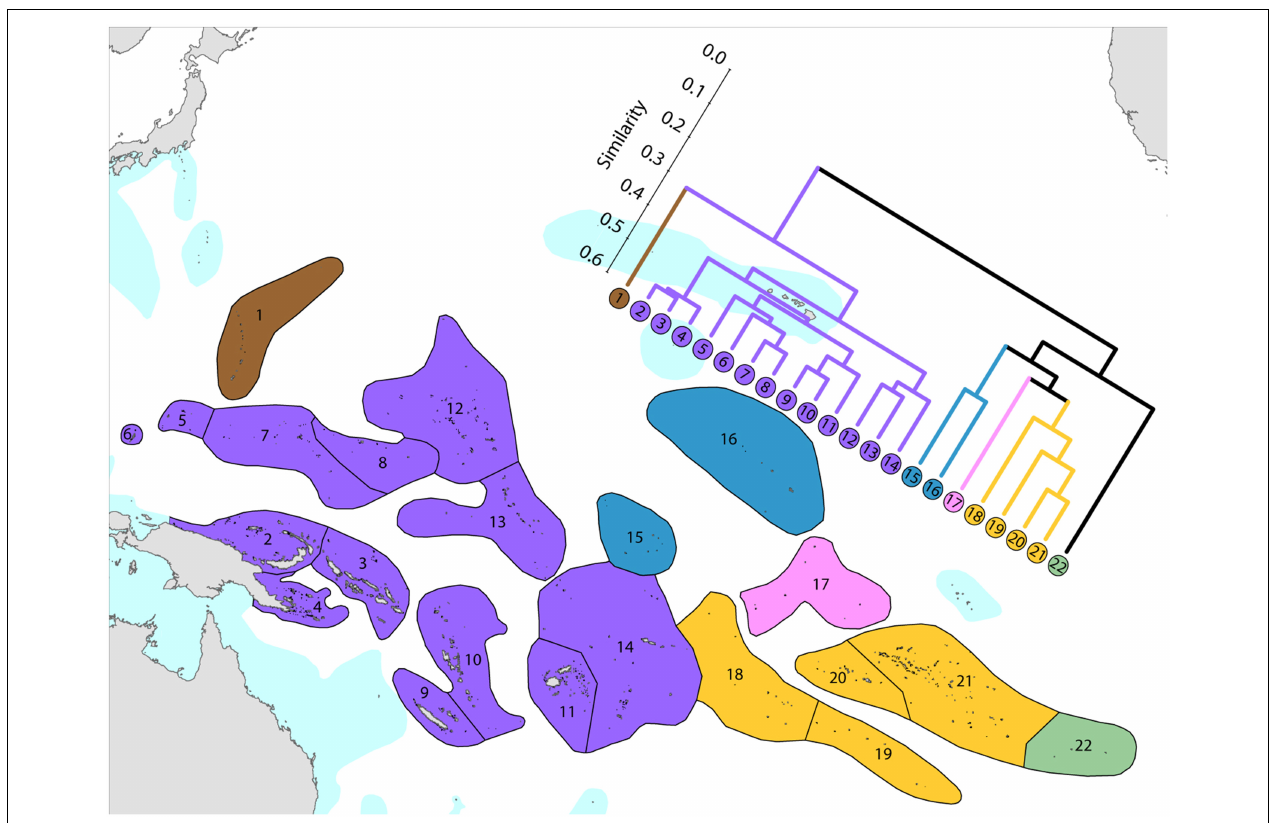
FIGURE 12 | Affinity and diversity of ecoregions of the central and western tropical Pacific. Ecoregions in the Coral Triangle (numbered 2–4) are strongly differentiated from other ecoregions. This dendrogram was